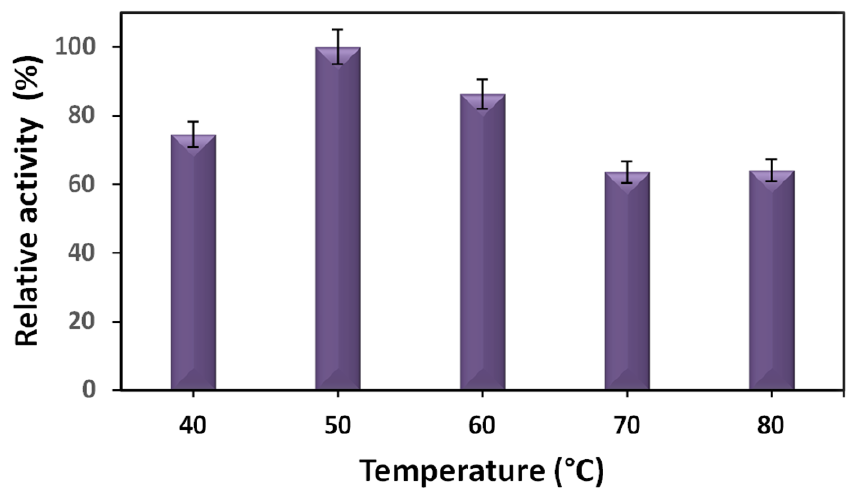
Figure 7. Temperature effect on the immobilized BCL by physical adsorption (PA) onto graphene oxide.